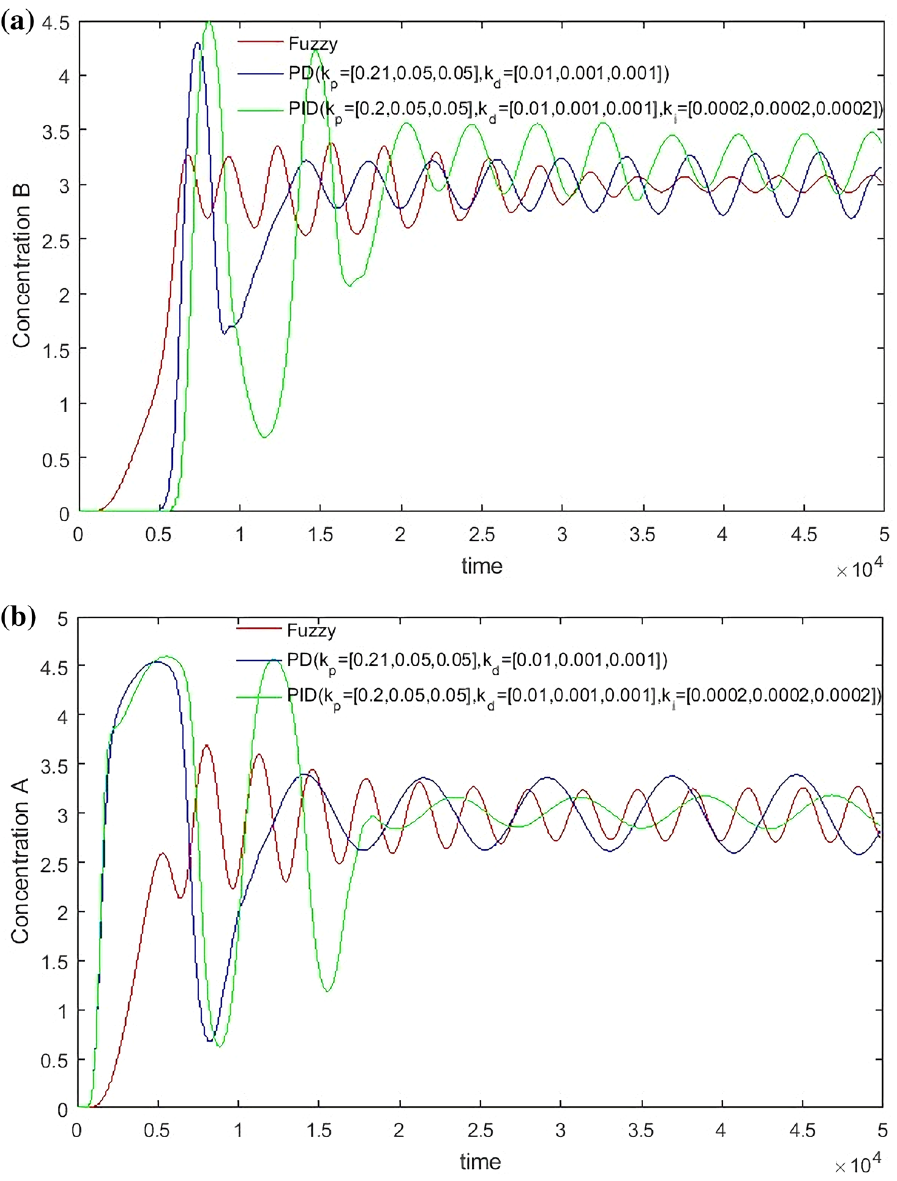
Figure 14. Desired B = 3, desired A = 3, Switch time = 180